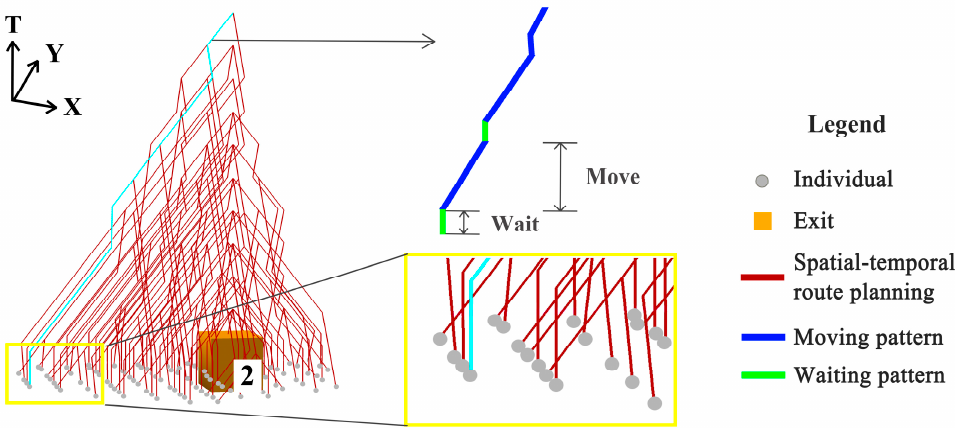
Figure 6. The waiting–moving patterns of individual spatio-temporal route planning to exit 2 ( t = 400 s).